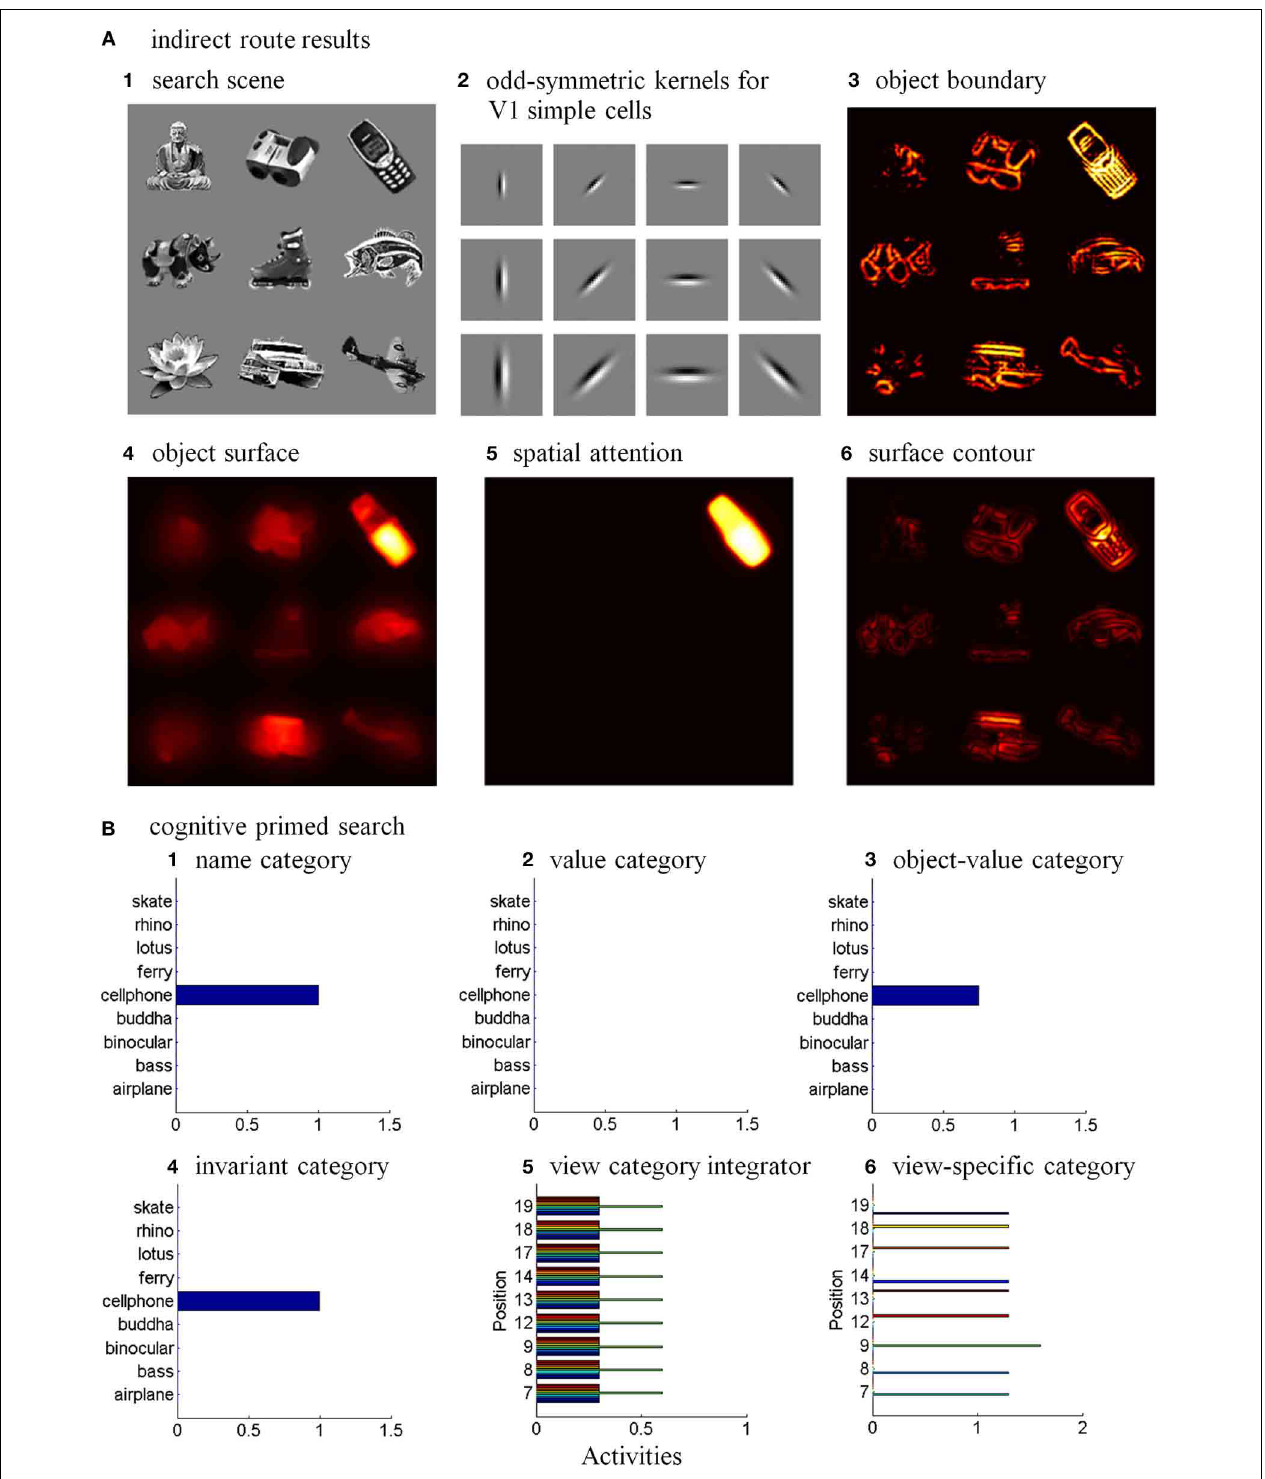
FIGURE 13 | Where’s Waldo cognitive primed search results. Search is based on positionally-and view-invariant object category learning of 24 objects, as illustrated in (A) . In (B) , a cognitive primed search are illustrated. (A) In the indirect route, the amplified view-specific category selectively primes the target boundary to make it stronger than other object boundaries